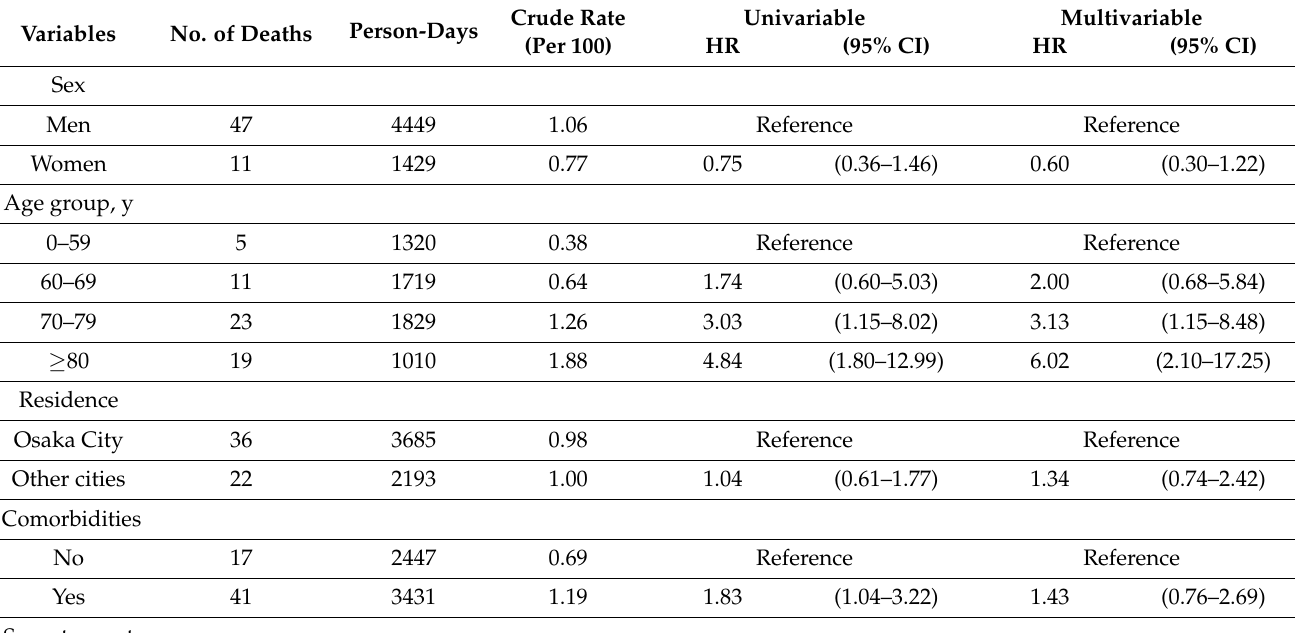
Table 3. Cox regression analysis of factors and mortality among intensive care unit patients in Osaka,